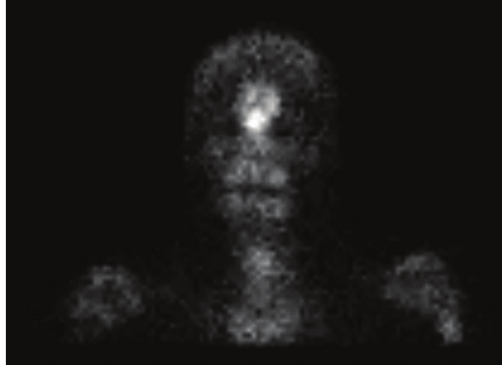
Figure 6: Bone scan showing increased uptake in the frontal